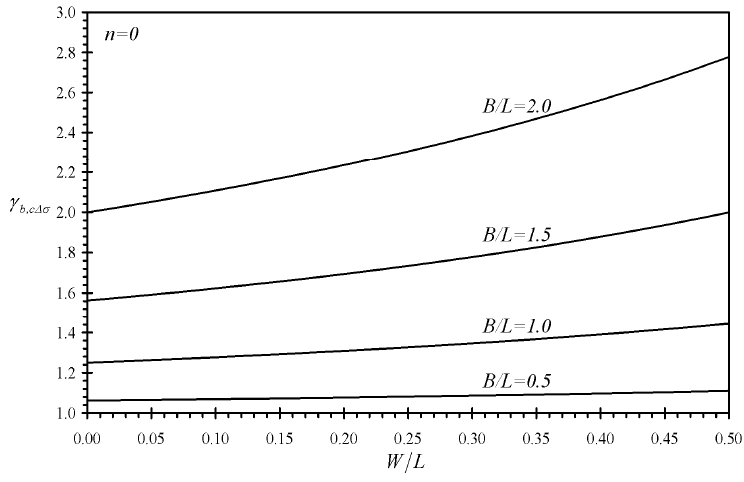
Figure 5. Effects of the relative dimensions of the microcantilevers assemblies (b) and (c) on the first performance indicators γ